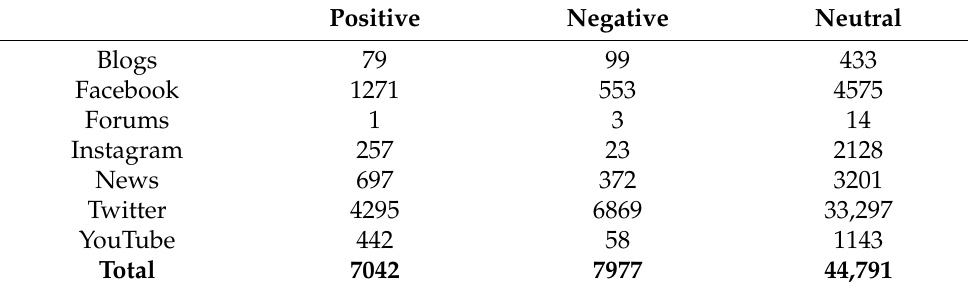
Table 1. The distribution of texts by polarity and channel.